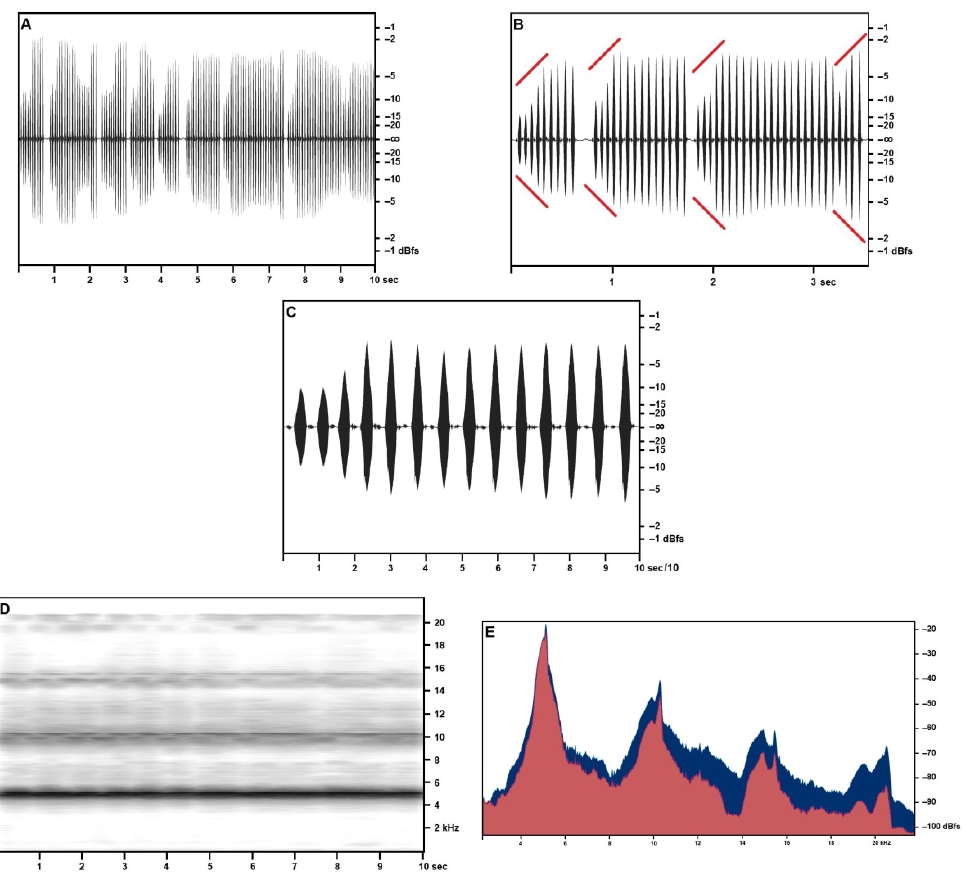
Figure 2. Acheta pantescus n. sp., calling/advertising Song, 44.1 kHz sampling frequency stereo recording—( A ), Right Channel—Sound Pressure Envelope (10 s); ( B ), Right Channel—Sound Pres- sure Envelope (3 s)—diverging red lines highlight crescendo; ( C ), Right Channel—Sound Pressure Envelope, 1-s trill; ( D ), Time/Frequency Spectrogram, 10 s; ( E ), Frequency/Sound Pressure analysis, scan on ten seconds, Right Channel in the foreground (red). Table 4. Harmonic structure of the July calling/advertising song of Acheta pantescus n. sp. in the high-quality stereo recordings, based on a sample size of 10 s.